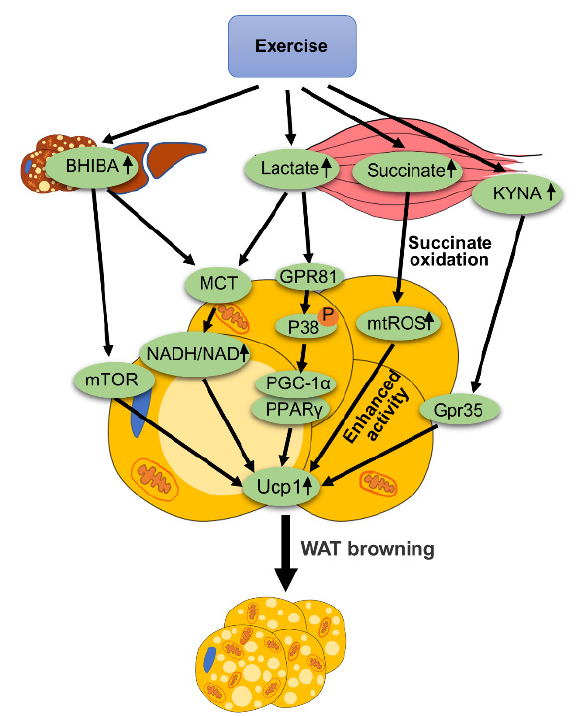
Figure 3. The role of metabolites in exercise-mediated WAT browning. Exercise increases BHIBA levels in the liver and skeletal muscle. BHIBA mediates the browning of WAT through the mTOR signaling pathway or elevated NADH/NAD + ratio. Exercise induces skeletal muscle to produce lactate. Lactate binds to receptor GRP81 on adipocytes, which promotes the phosphorylation of P38, leading to the increased expression of PGC-1 α and PPAR γ . This process ultimately increases Ucp1 expression. Exercise increases the level of succinate. Oxidation of succinate can increase the mtROS level and enhance the activity of Ucp1. Exercise promotes KYNA release in skeletal muscle, which binds to and activates Gpr35 on adipocytes. This process also leads to WAT browning.